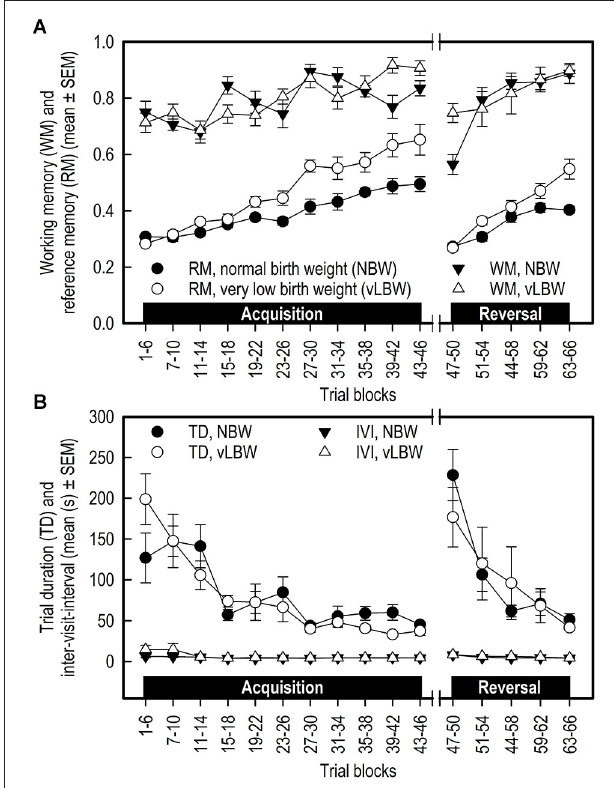
FIGURE 2 | (A) Working memory (WM) and reference memory (RM) performance and (B) Trial duration (TD) and inter-visit interval (IVI) of NBW ( n = 10) and vLBW ( n = 9) piglets in the spatial cognitive holeboard task during the acquisition phase (trials 1–46) and the reversal phase (trials 47–66). Note that TD and IVI were analyzed statistically after log 10 transformation whereas the untransformed means and SEMs are depicted